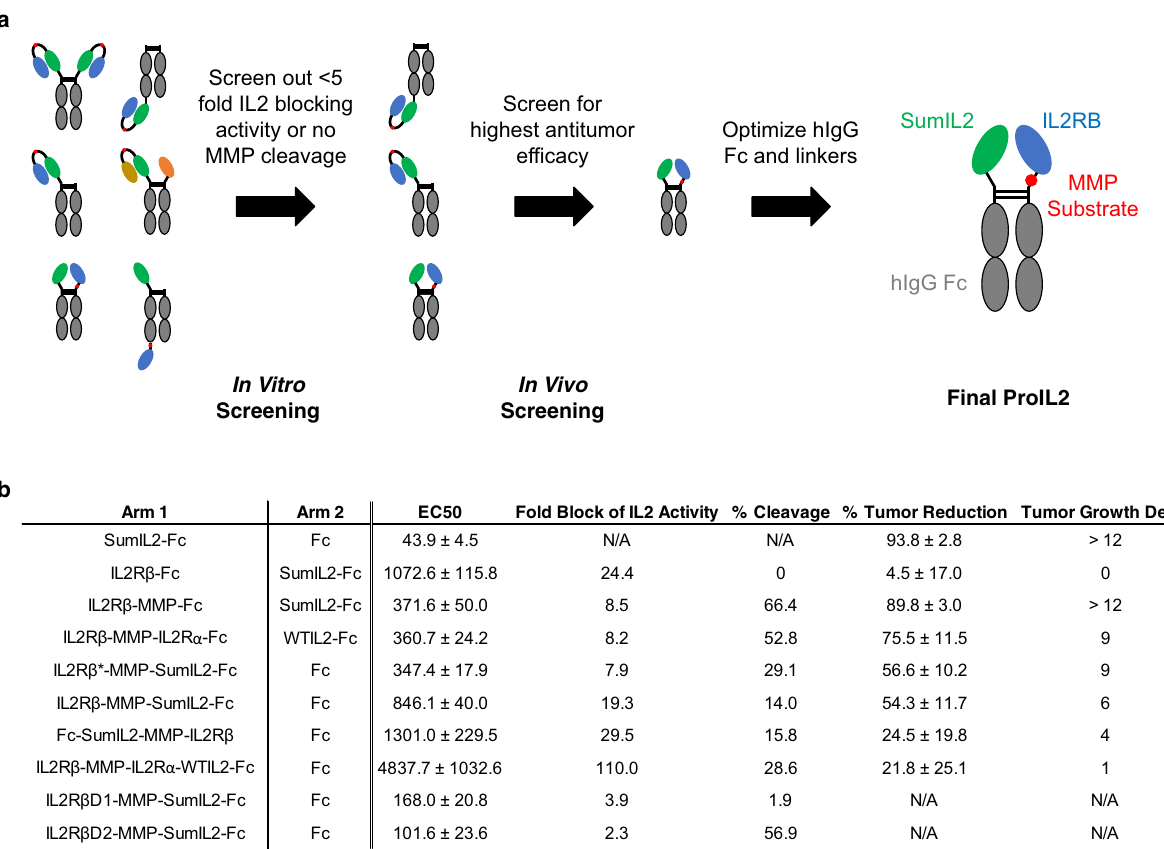
Fig. 1 Engineering ProIL2 design. a Pipeline for designing and screening the most optimal ProIL2 designs. ProIL2 designs were screened using HEK-Blue TM IL-2 reporter cell assay, MMP cleavage assay for 4 h, and tumor inoculation and growth measurement as described in the “ Methods ” . b Multiple designs of ProIL2 were tested. The Fc arms, listed from N terminus to C terminus in each entry, of each proposed design are shown. HEKBlue TM IL-2 reporter cell assay was used to determine the EC50 in nM of functional activity of each ProIL2 design. Fold block of IL-2 activity was measured by dividing the EC50 of each ProIL2 design to that of SumIL2-Fc. To compare between experiments, SumIL2-Fc EC50 and construct EC50 were normalized to the displayed EC50 value. Each ProIL2 design was cleaved by MMPs and run on SDS-PAGE, where the amount of cleaved vs uncleaved ProIL2 product was quanti fi ed. MC38 s. c. tumor-bearing mice were injected i.p. with PBS and an equimolar dose of the listed ProIL2 design 9 days after tumor inoculation. 12 days after treatment, tumor volumes of PBS-treated and ProIL2-treated mice were measured, and the decrease in tumor volume in ProIL2-treated mice on this day was quanti fi ed. Tumor growth delay is de fi ned as the difference in days it takes for treatment vs PBS groups to reach an average MC38 tumor volume of 150 mm 3 . Abbreviations: IL2R β = IL-2 receptor beta, IL2R β * = truncated version of IL-2 receptor beta, MMP = 10-mer cleavable MMP substrate, IL2R α = IL2 receptor alpha, WTIL2 = wild-type IL-2, IL2R β D1 = IL-2 receptor beta domain 1, IL2R β D2 = IL-2 receptor beta domain 2. Data represent mean ± s.e.m. ( n = 4 individual mice per group). Source data are provided as a Source Data fi